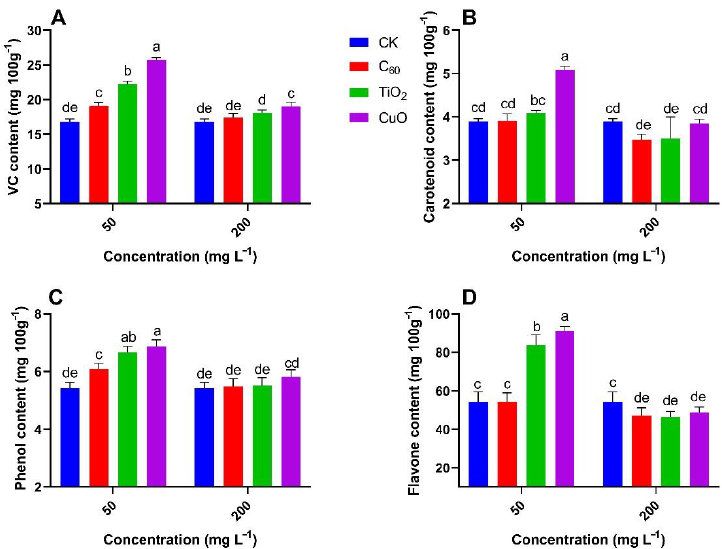
Figure 9. Effect of NMs treatment on the mean content (n = 3) of ascorbic acid ( A ), carotenoids ( B ), total phenol ( C ), and total flavones ( D ) in sweet potato (Y25) exposed to soft rot disease. Different small letters represent significant difference according to Duncan’s multiple range test ( p < 0.05. n = 3).